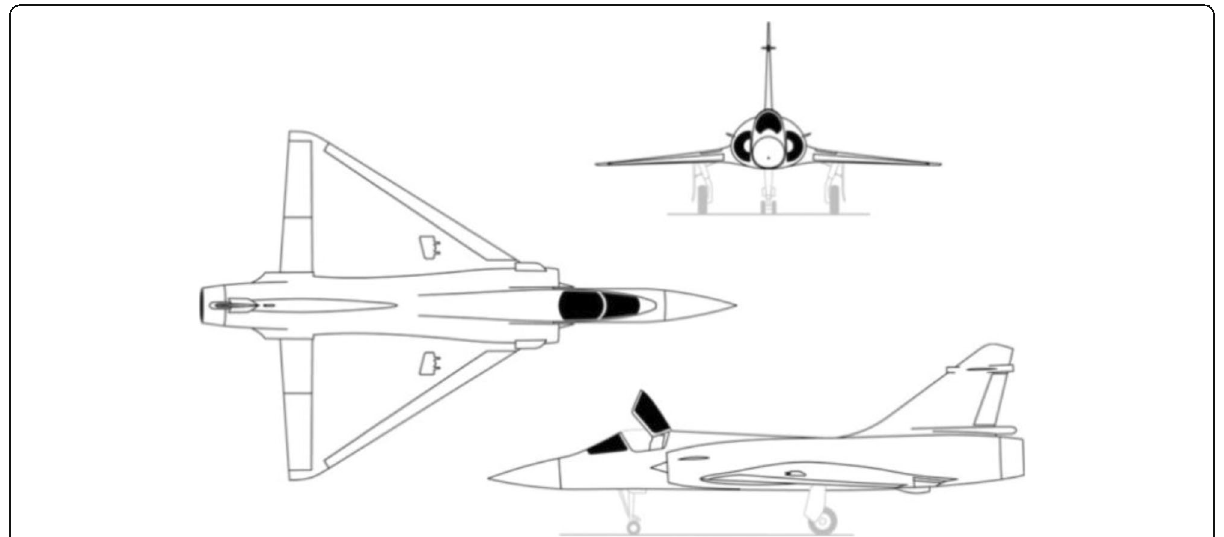
Fig. 4 Example of an airplane that haves Delta wings (Mirage 2000C). See